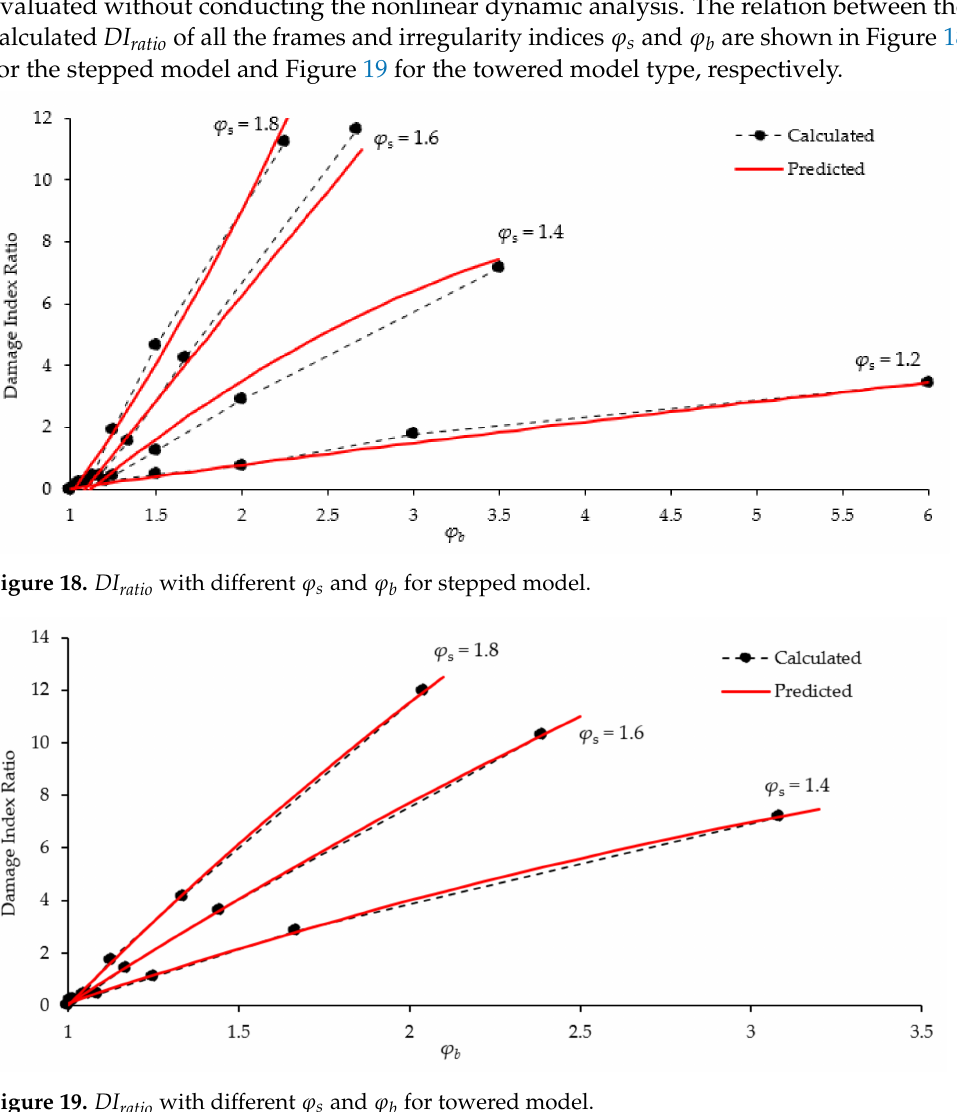
Figure 19. DI ratio with different ϕ s and ϕ b for towered model. Values of ϕ s and ϕ b equal to 1 correspond to a structure with a uniform configuration. As values of ϕ s and ϕ b increase, the degree of the setback in the frame structure becomes larger. A large value of DI ratio indicates a relatively large damage concentration in the tower. for estimating the damage index ratios from irregularity indices, ϕ s and ϕ b . The obtained equations are shown in Equation (13) for stepped type and Equation (14) for towered type. The red lines in Figures 18 and 19 indicate the prediction of the damage index ratio using Equations (13) and (14). The values of R-squared of red lines, which indicate the goodness-of-fit measure for the regression model, vary between 0.865 and